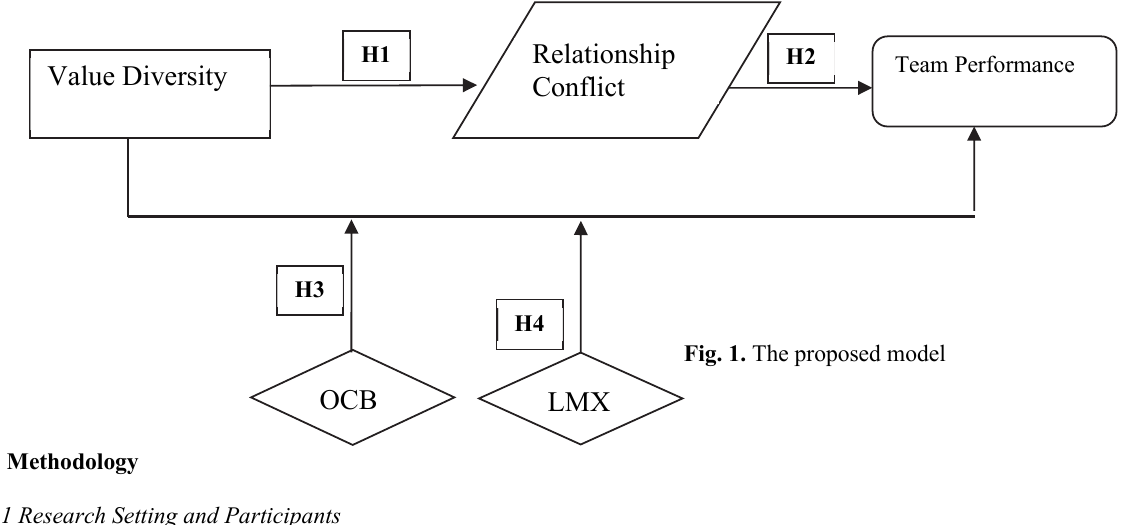
Fig. 1. The proposed